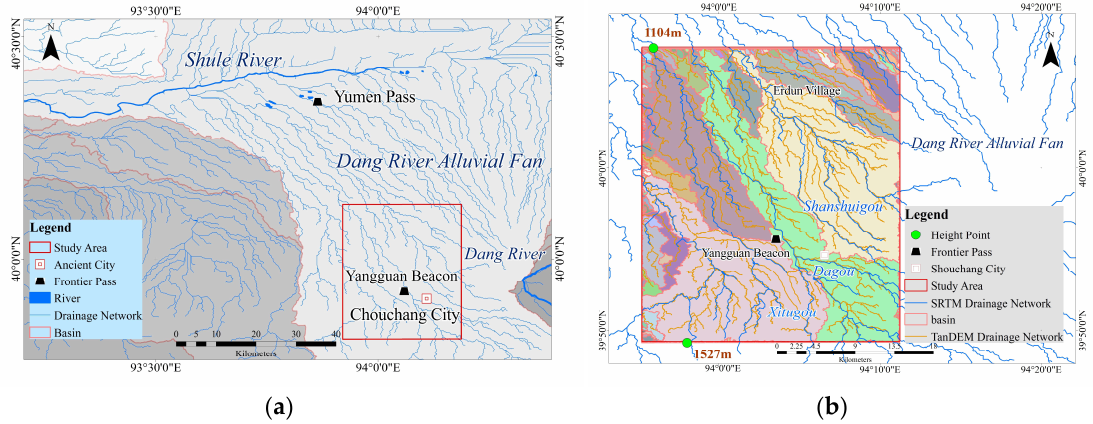
Figure 5. ( a ) Watershed and drainage network extracted based on the 30-m SRTM DEM. ( b ) Watershed and drainage network extracted using the 5-m TDX DEM.